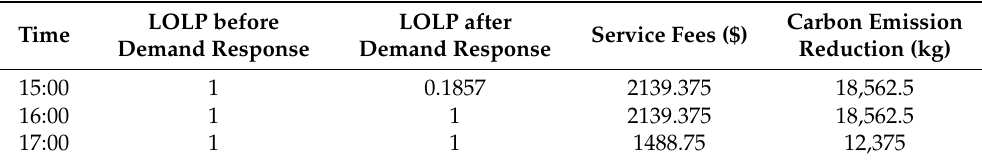
Table 7. Loss of energy probability.